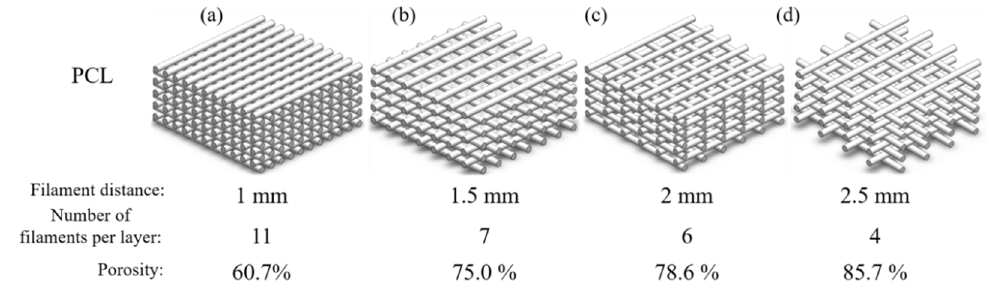
Figure 3. Porosity values as a function of filament distance, ( a ) 1 mm, ( b ) 1.5 mm, ( c ) 2 mm, and ( d ) 2.5 mm for the different designed PCL